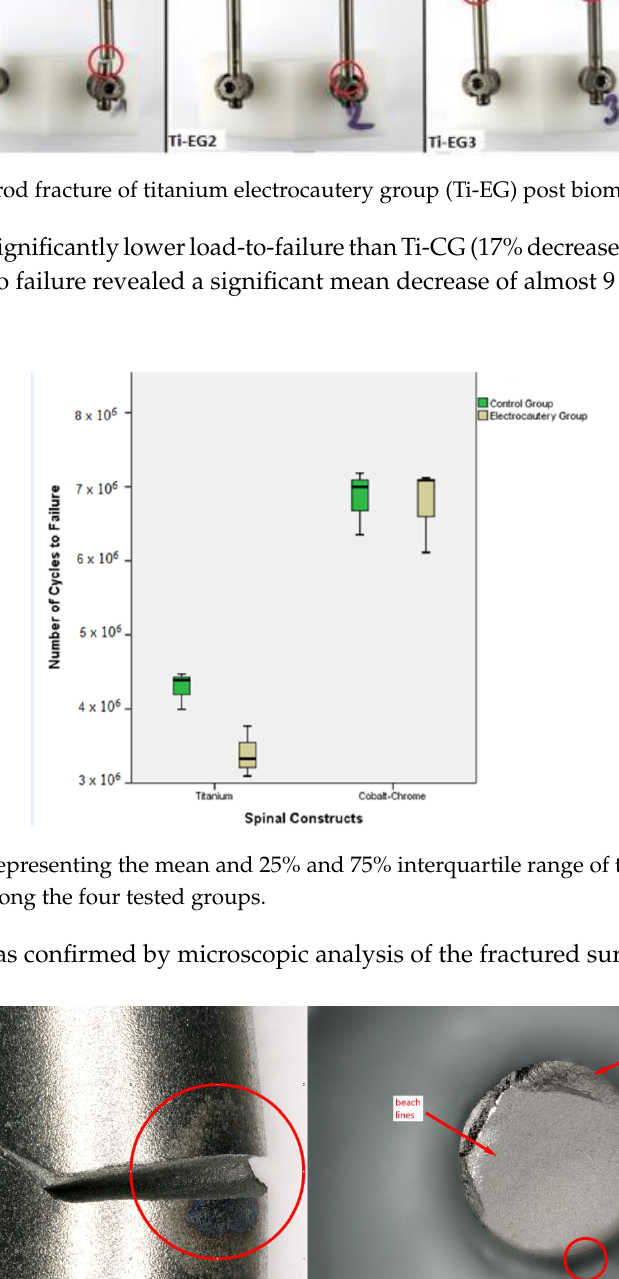
Figure 3. Sites of rod fracture of titanium control group (Ti-CG) post biomechanical testing and fatigue fractures of the rods at the rod-screw junction.